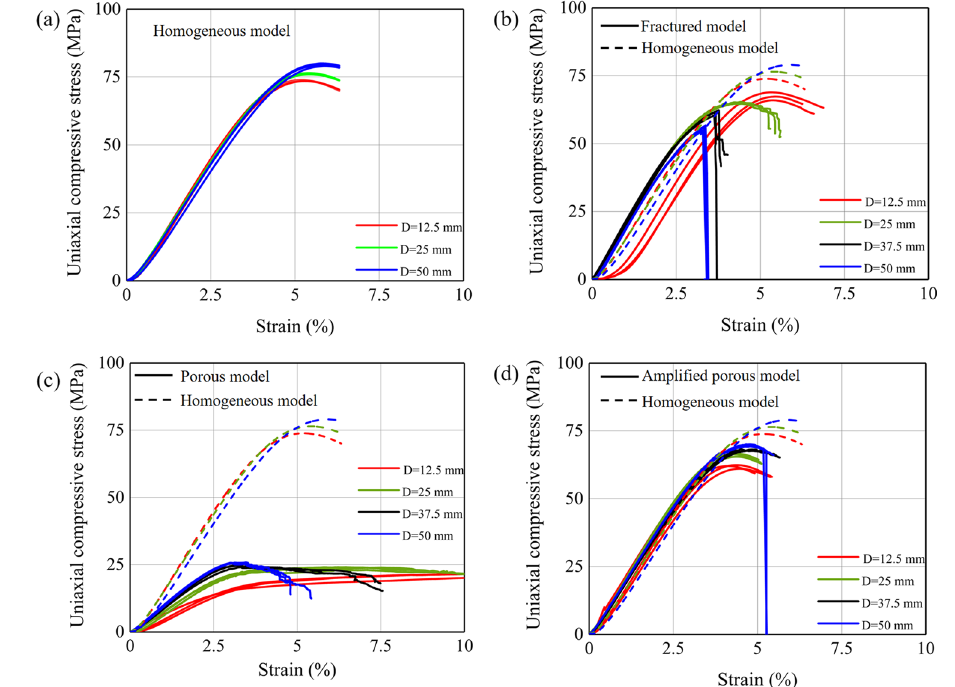
Fig. 7 Stress–strain curves of the printed models with and without internal discontinuous structures. a Homogeneous model; b Fractured model with real cleavages; c Porous model with real pores; d Amplified porous